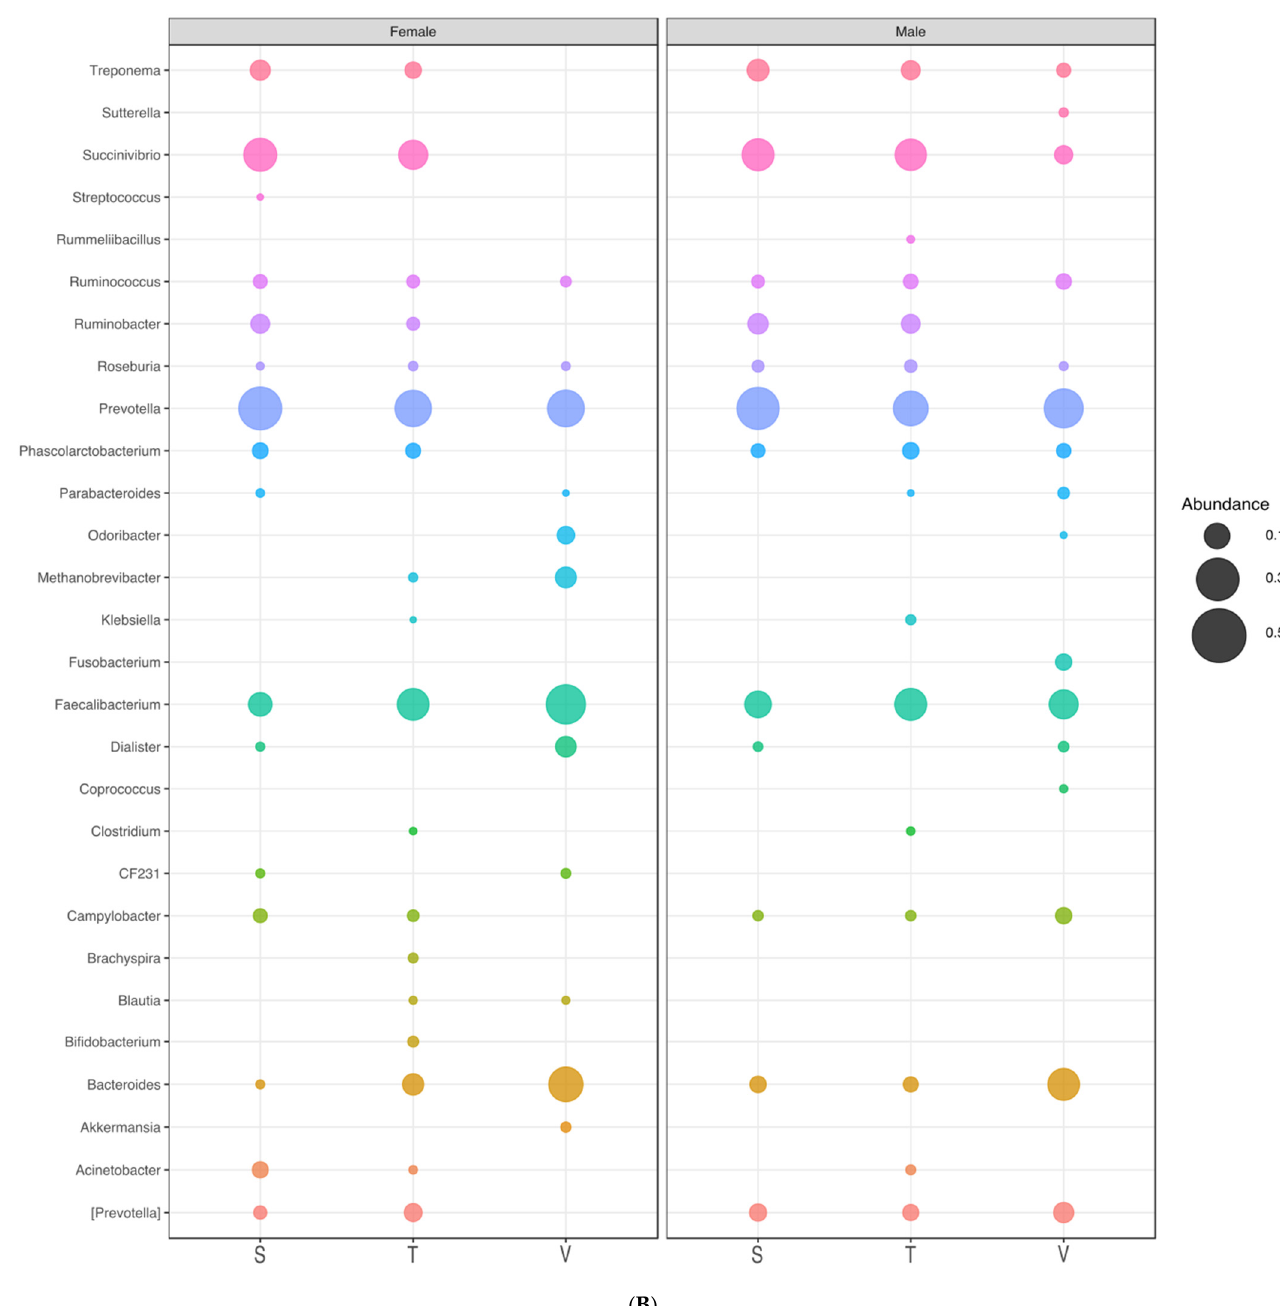
Figure 4. ( A ) Community composition by gender. Phylum distribution, unfiltered. Siminke (S), Tezhumake (T) and Valledupar (V). ( B ) Community composition by gender. Genera distribution (Genera > 2%). Siminke (S), Tezhumake (T) and Valledupar (V).